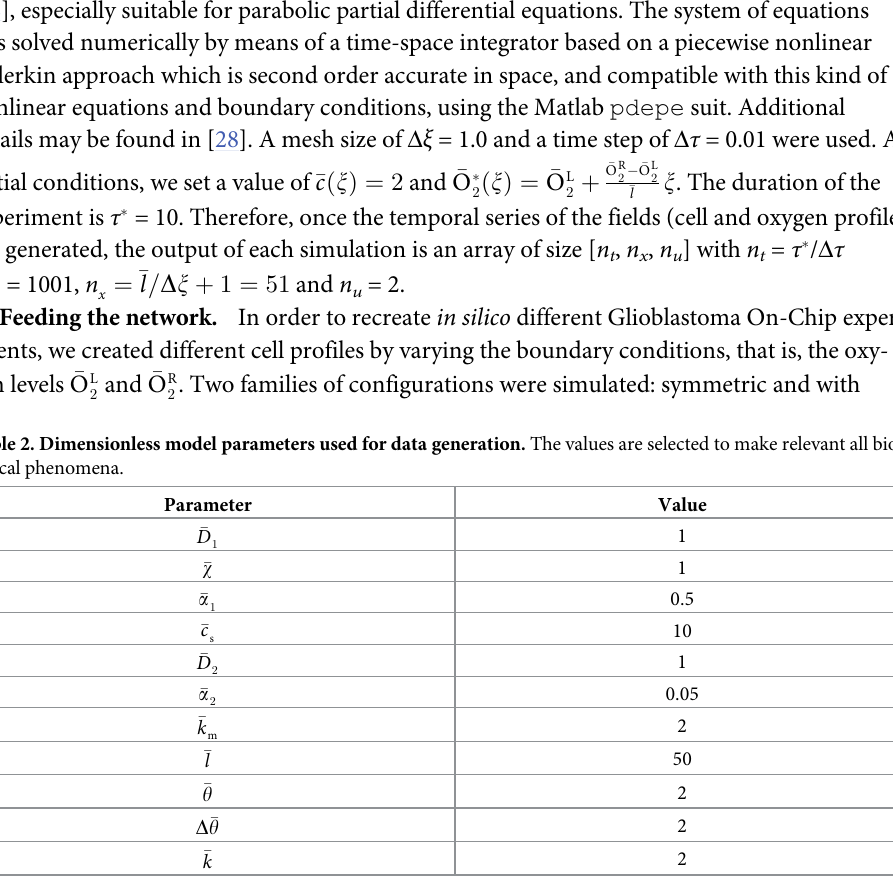
1 0.5 10 1 0.05 2